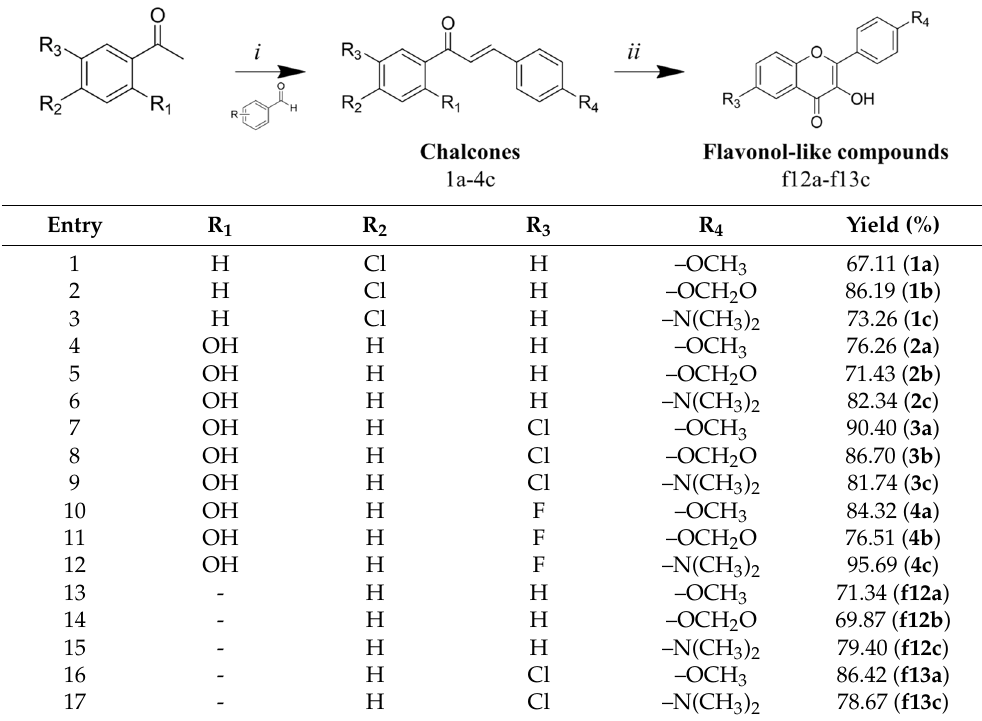
Table 1. Reaction yields of chalcone and flavonol-like compounds.